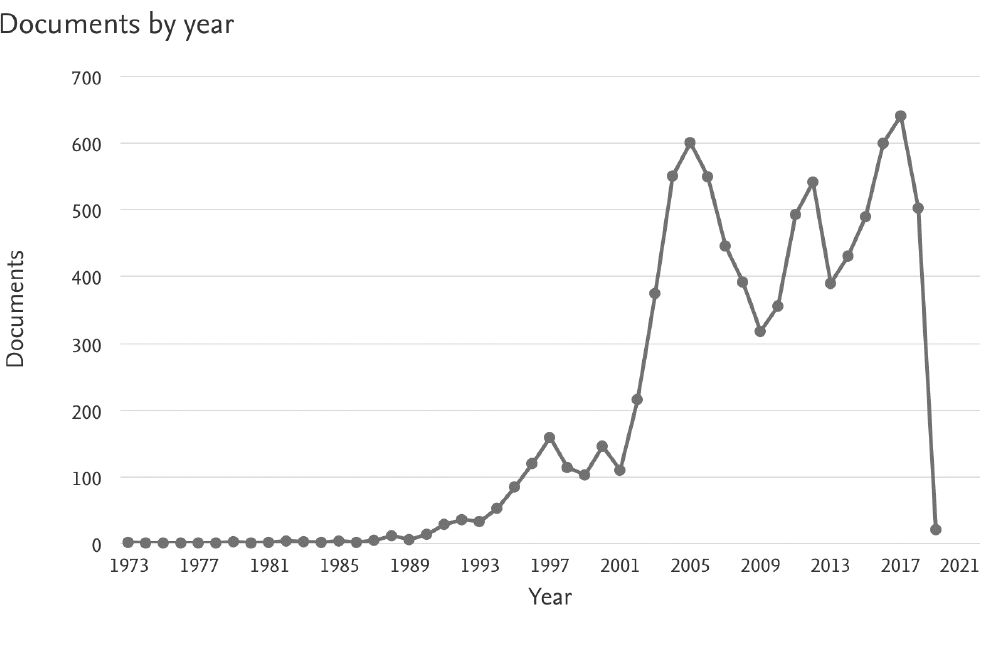
Fig. 1. Documents by year in SCOPUS using the search: KEY (innovation) AND (LIMIT-TO